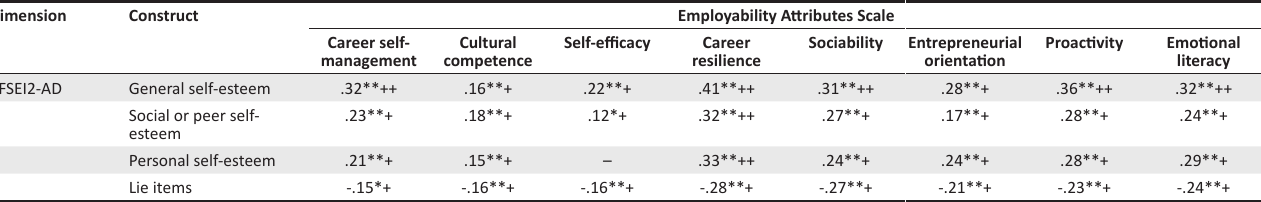
TABLE 4: Pearson-product moment correlations – Culture Free Self-Esteem Inventory and Employability Attributes Scale. Dimension